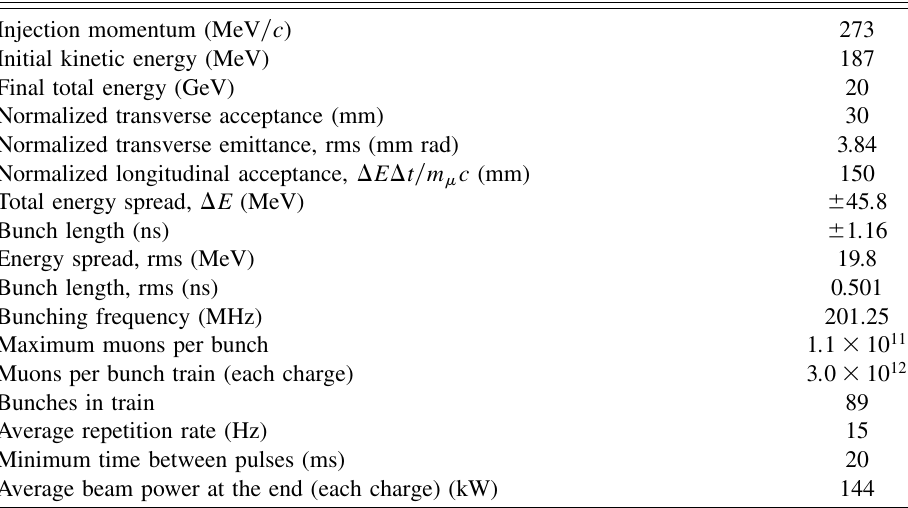
TABLE III. Acceleration system design parameters.